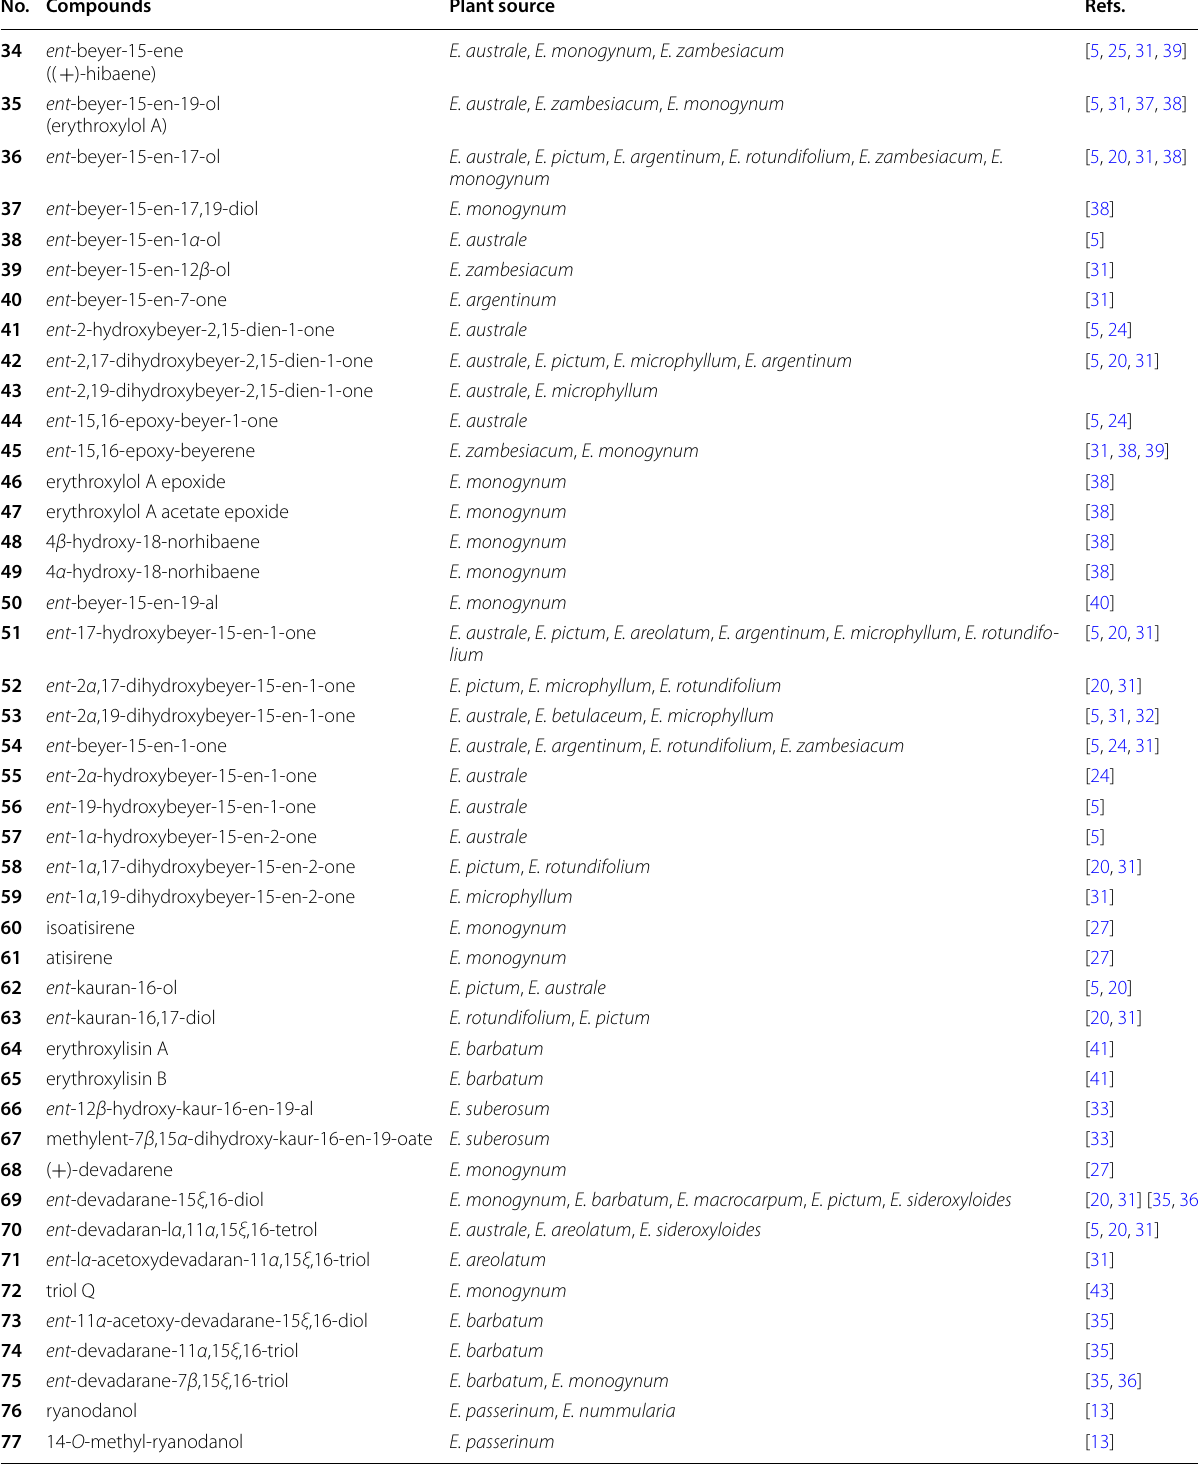
Table 4 Tetracyclic diterpenes isolated from Erythroxylum plants No. Compounds Plant source